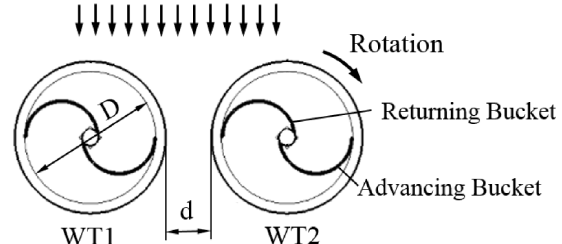
Fig. 4. De fi nitions of design parameters for rotors arrayed side- by-side.